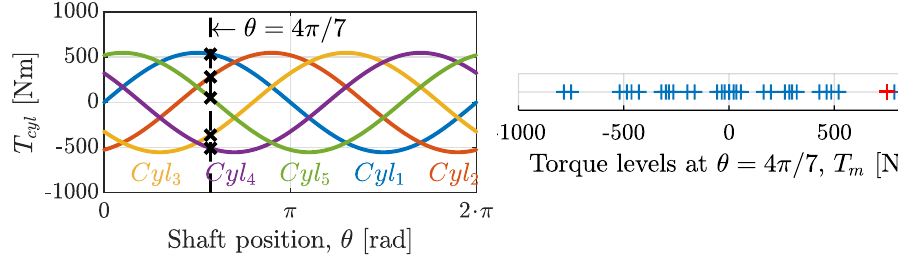
Figure 7. Cylinder torque ( left plot ) and possible torque levels at θ = 4 π /7 ( right plot